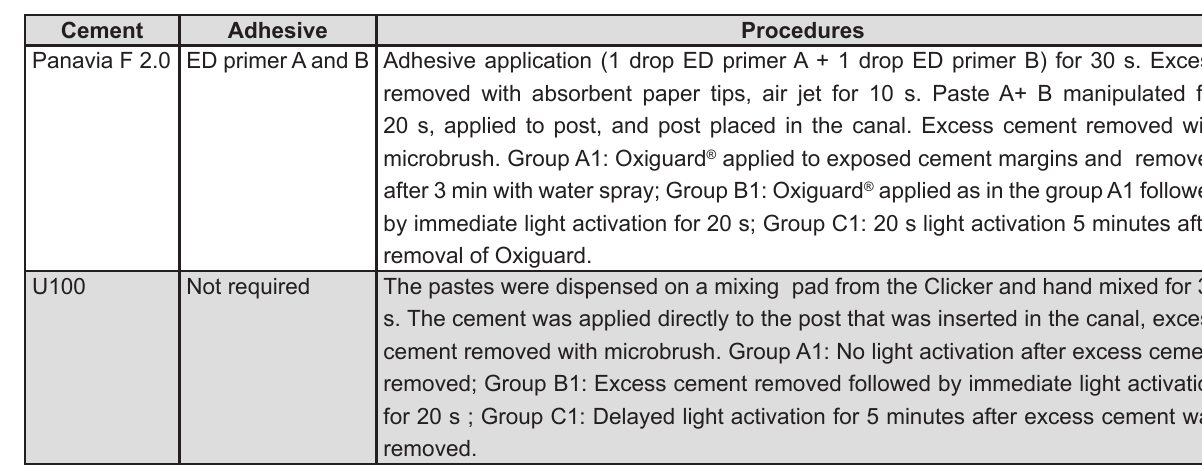
Figure 3- Cementation